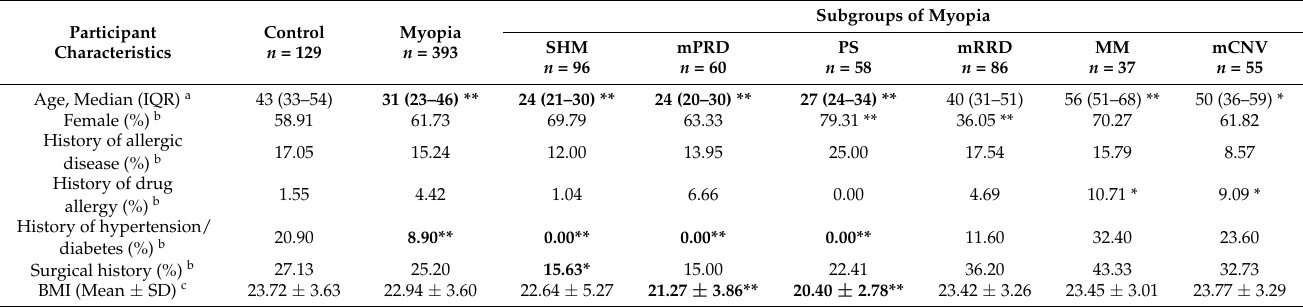
Table 1. Demographic and clinical characteristics of study